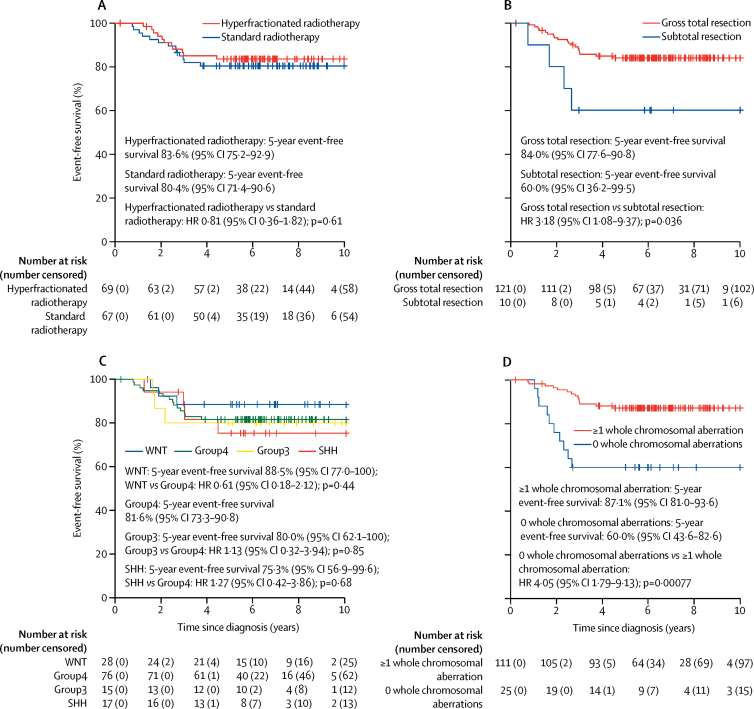
Event-free survival in the HIT-SIOP PNET 4 cohort by clinical and disease-associated molecular featuresPatients (n=136) were grouped as (A) treated with standard radiotherapy vs hyperfractionated radiotherapy, (B) those who had a gross total resection vs subtotal resection, (C) classified as per the four consensus medulloblastoma molecular subgroups, and (D) those with or without whole chromosomal aberrations. Event-free survival for patients with non-WNT/non-SHH disease (n=91) grouped as (E) patients with MYCN amplified vs non-amplified tumours, (F) patients with medulloblastomas presenting an i17q or not, and (G) patients with medulloblastomas with or without whole chromosomal aberration. HR=hazard ratio.